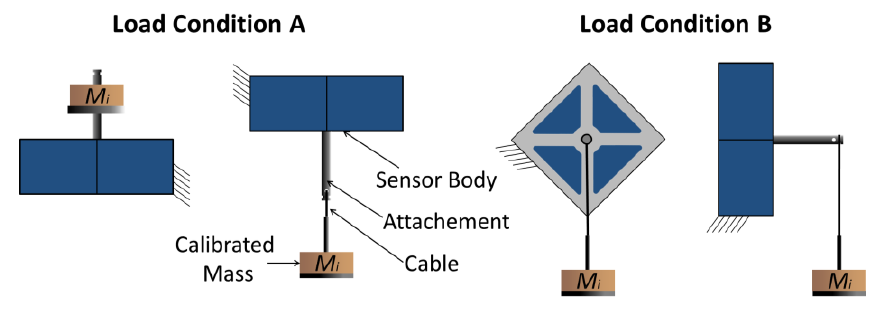
Figure 13. Scheme of the characterization procedure for the two different load